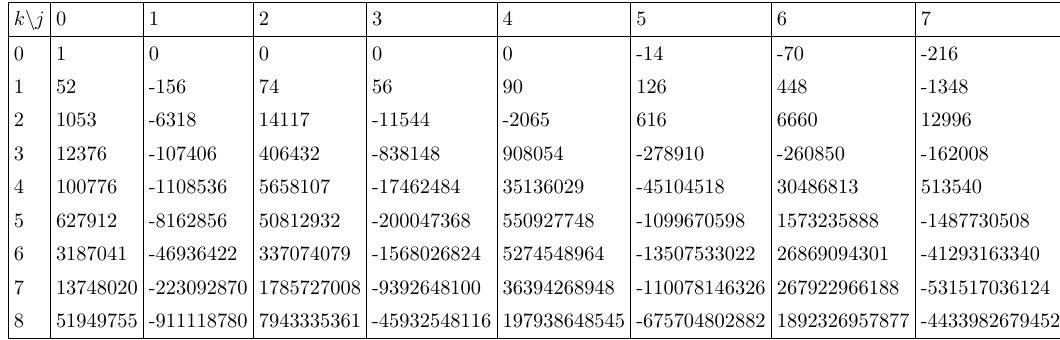
Table 55. Table of b jk coe(cid:14)cients for h F 4